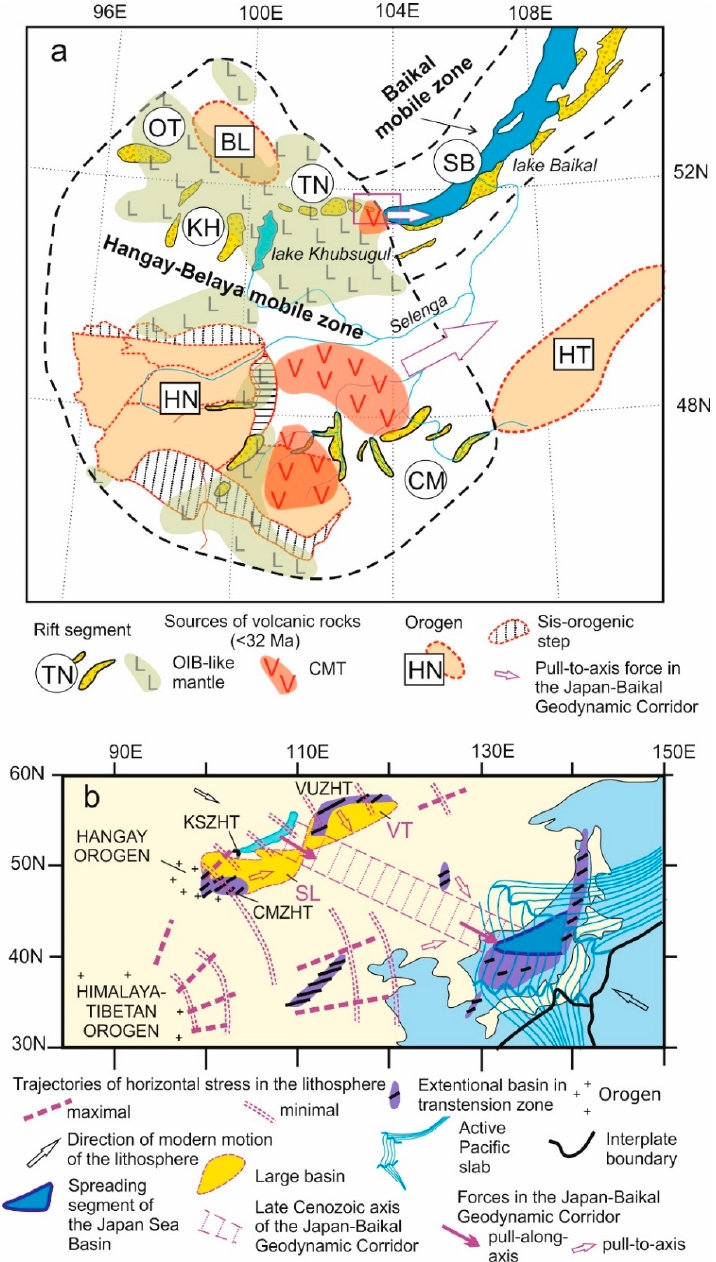
Figure 20. Transition from the “hot” (volcanic) Hangay-Belaya mobile zone of the BRS to its “cold” (non-volcanic) Baikal mobile zone ( a ) and spatial relationship between pull-to-axis forces in the Japan-Baikal geodynamic corridor and trajectories of tectonic stress caused by the Indo-Asian convergence ( b ). Panel a shows large basins (SL, Selenga) and (VT, Vitim), hot transtension zones in the central part of the BRS (KSZHT, Kamar-Stanovoy), in its southwestern part (CMZHT, Central Mongolian), and in its eastern part (VUZHT, Vitim-Udokan). Panel b shows rift segments (letters in circles: jectories are shown after [130,131]. The pull-to-axis force of the geodynamic corridor is weakly displayed along the South Baikal Basin in magmatic activities of crust–mantle sources in the KSZHT and is more distinct in magmatic activities of crust-mantle sources of the vast area in the Selenga River basin and East Hangay Orogen in the CMZHT.